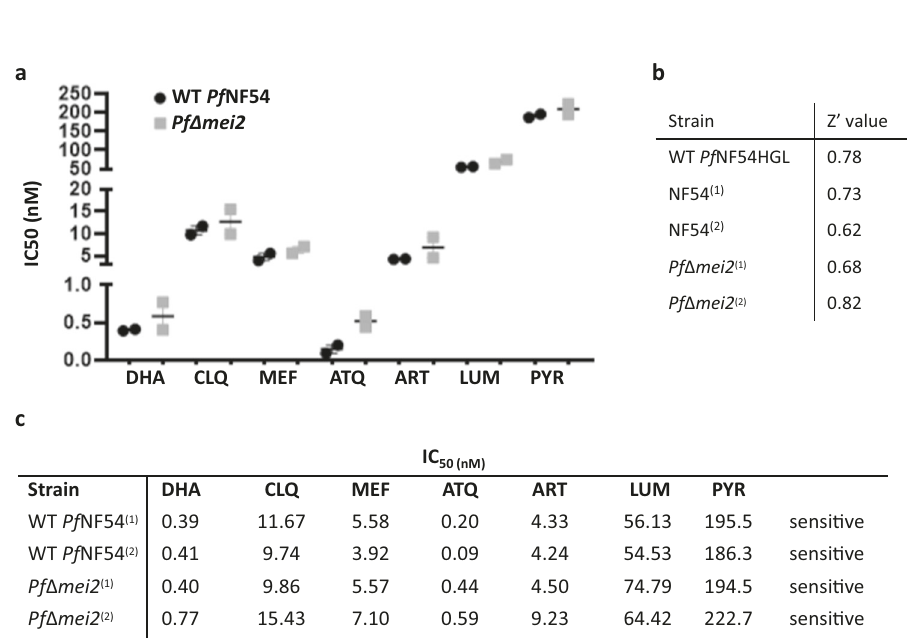
Fig. 5 Sensitivity of Pf Δ mei2 and WT Pf NF54 blood stages to seven antimalarial drugs. a Drug sensitivity of Pf Δ mei2 (gray) and WT Pf NF54 (black) to seven antimalarial drugs was determined in an asexual Blood stage (ABS) SYBR Green drug assay. The graph shows the IC50 value with standard error of the mean (SEM) (see c below for the exact values). DHA dihydroartemisinin, CLQ chloroquine, MEF me fl oquine, ATQ atovaquone, ART, artemisinin, LUM lumefantrine, PYR pyrimethamine. b Z ’ values for each tested Plasmodium falciparum strain. The Table shows the Z ’ values for each of the plates tested in the ABS replication assay. c IC50 values for each culture for the drugs shown in a . IC50 was determined using a four-parameter non-linear regression model using least-squares to fi nd the best fi t. Error bars represent the standard error of the